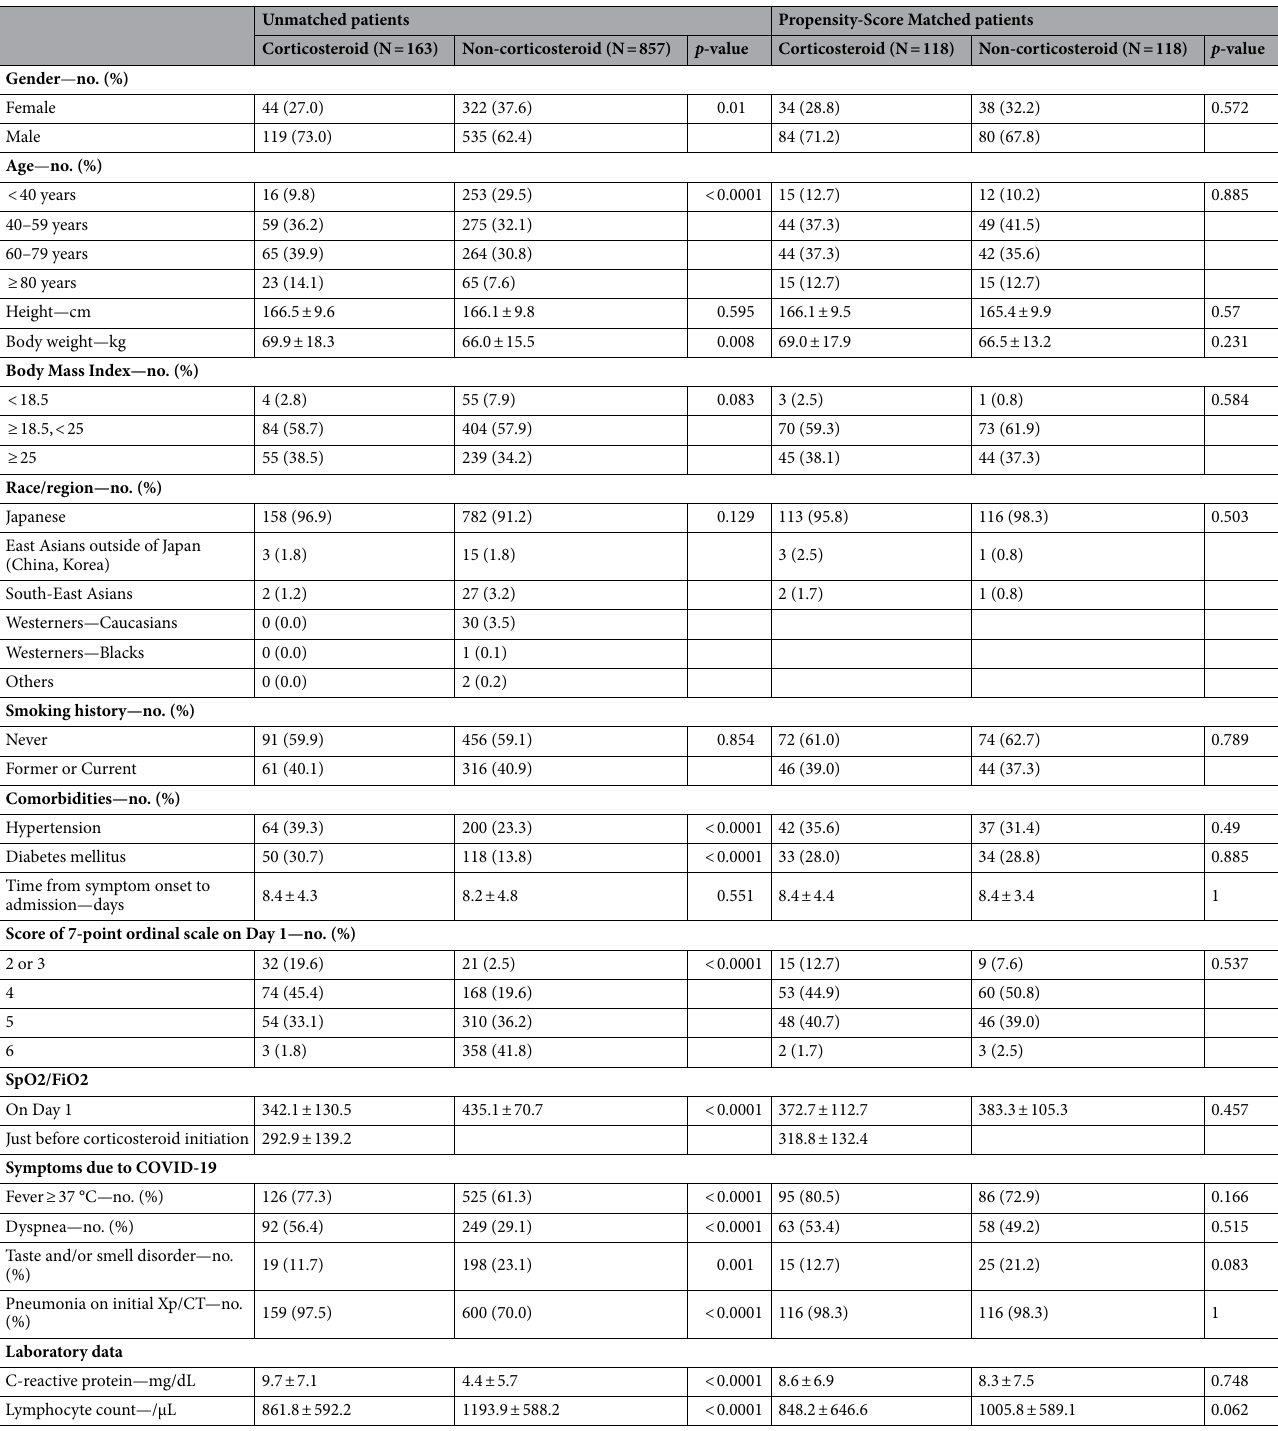
Table 1. Baseline characteristics before and after propensity score matching. Unmatched patients refer to the total of 1020 enrolled patients (163 patients who received early corticosteroids for COVID-19 and 857 patients who did not receive systemic corticosteroids for COVID-19) subject to propensity score matching in this study. Because only a few patients had a baseline 7-point ordinal score of 3, the patients with a baseline score of 2 and 3 were combined for the analysis. Categorical variables were presented as numbers (%), and compared using the chi square test. Normally distributed continuous variables were presented as mean and standard deviation (SD), and compared using the t test. A p value of < 0.05 was considered statistically significant. COVID-19, coronavirus disease 2019; CT, computed